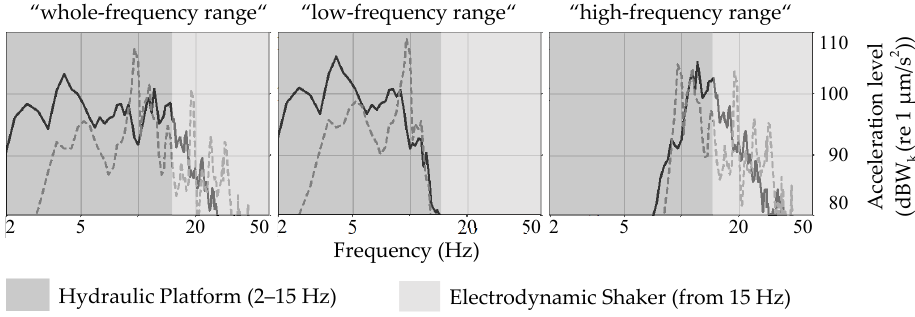
Figure 4. Spectra of the selected frequency ranges of vertical seat vibrations and reproduction range of the used systems.